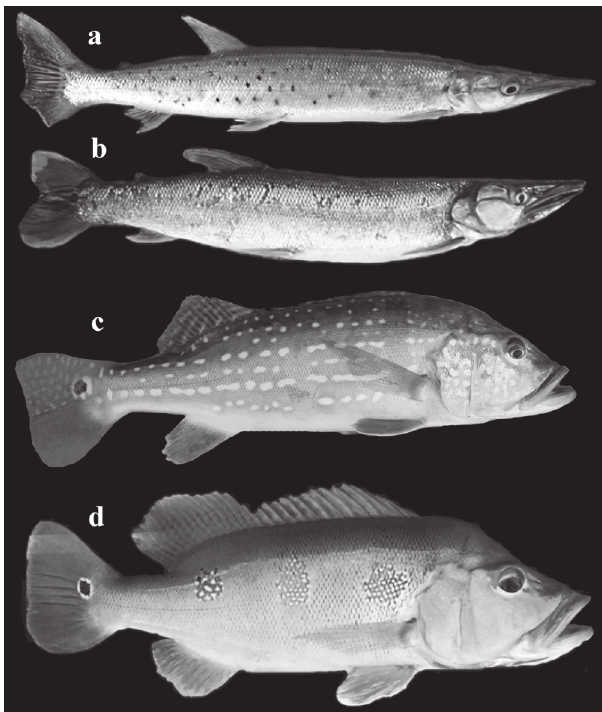
Fig. 2 . Photographs of representative individuals of the focal species in this study (not preserved). From top: a) Boulengerella cuvieri (SL= 320 mm), b) Boulengerella lucius (SL= 420 mm), c) Cichla temensis (SL= 360 mm), d) Cichla Fig. 3 . Relationship between standard length and gape width for the four predator